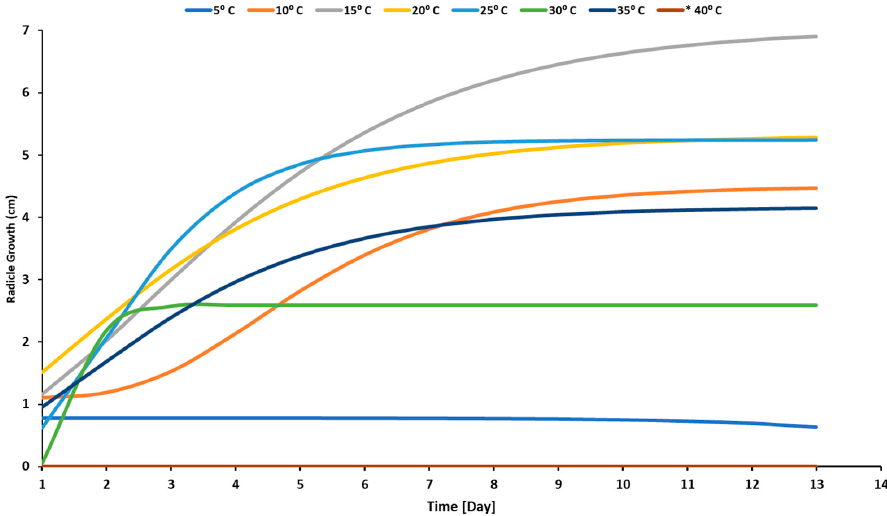
Figure 3. Effect of temperature levels on the growth response of radicle. The * represents 40 °C which is not shown on the graph because its value is zero (no radicle development).